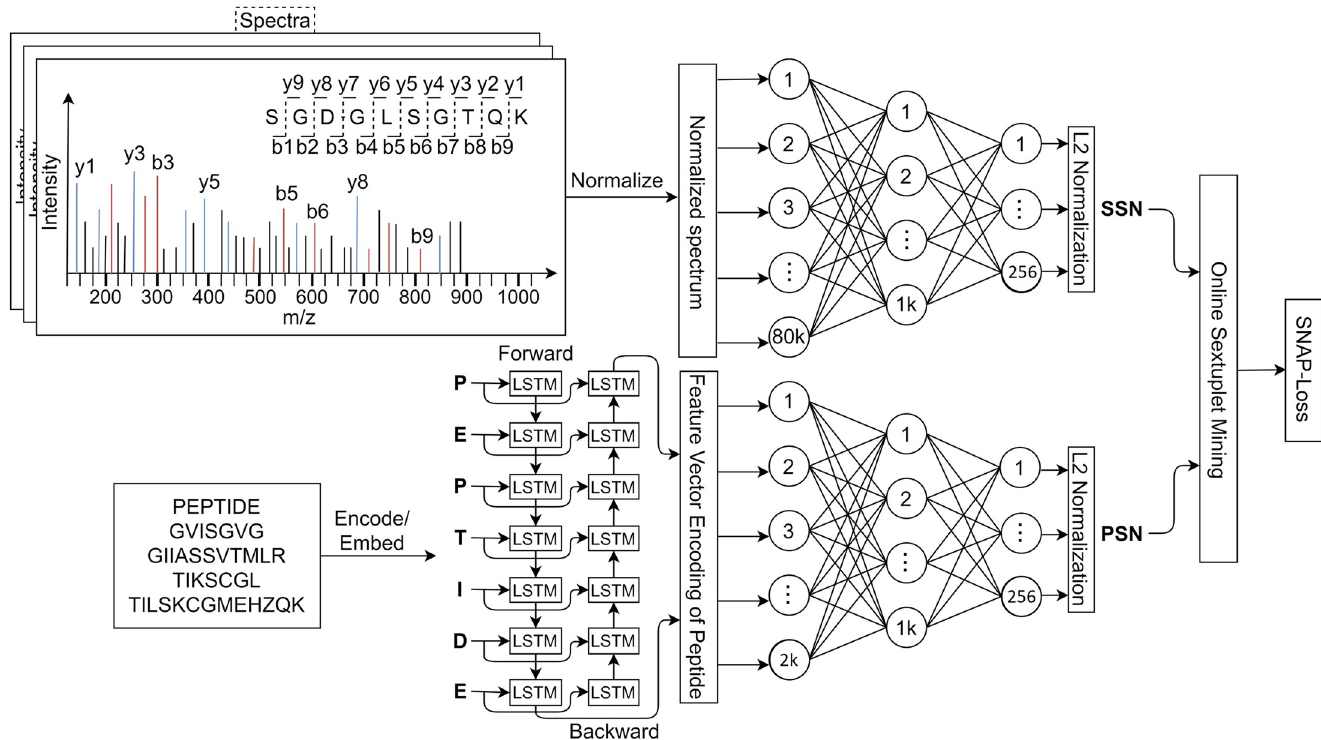
Fig 4. SpeCollate: Deep Similarity Network for proteomics. The spectra Q are passed to SSN in the form of sparse one-hot normalized representation. The positive and negative peptides (P, N) are passed to PSN one by one in both forward and backward direction.